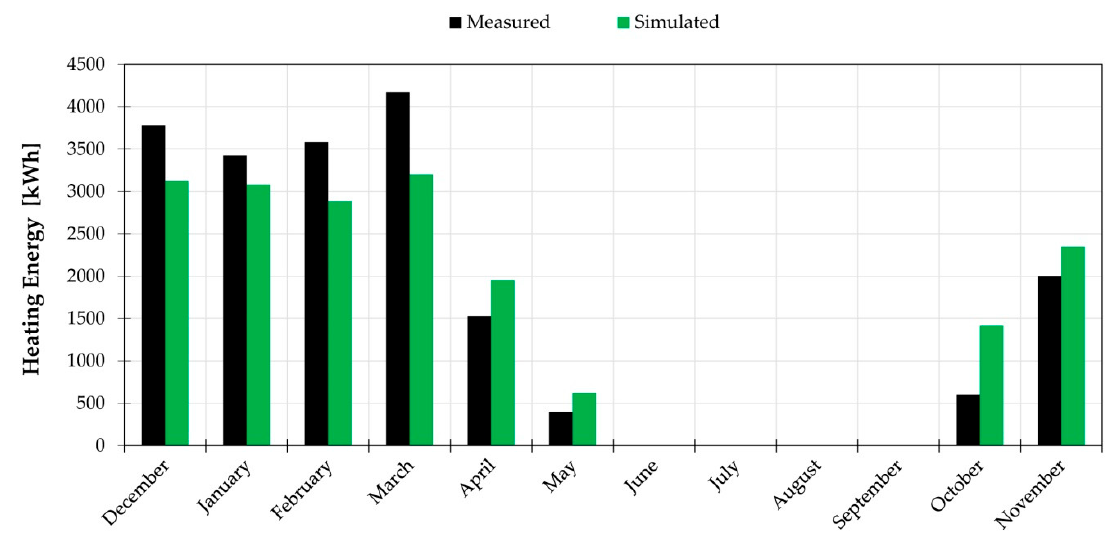
Figure 10. Building-system model annual validation based on data of gas consumption for heating.